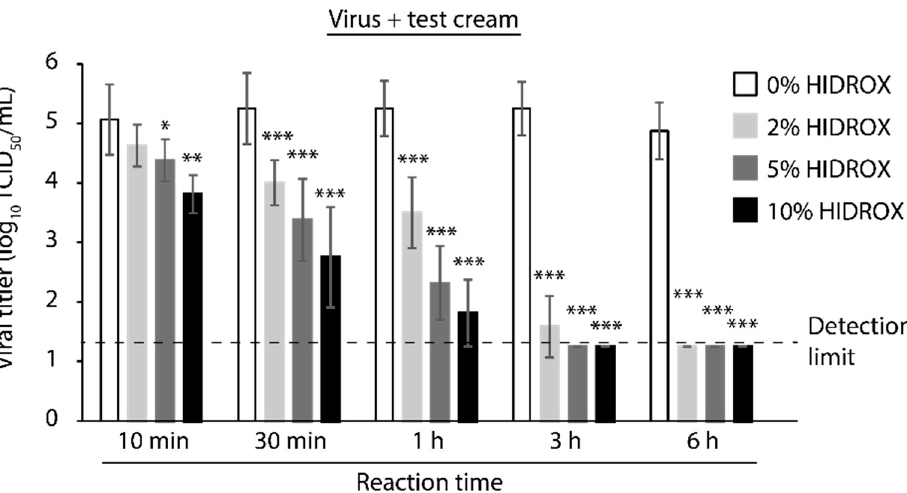
Figure 6. Time- and concentration-dependent virucidal activity of hydroxytyrosol (HT)-rich aqueous olive pulp extract (HIDROX)-containing cream against severe acute respiratory syndrome coronavirus 2 (SARS-CoV-2). SARS-CoV-2 was covered by 0%, 2%, 5%, and 10% HIDROX-containing cream-coated films and incubated for 10 min–6 h at 25 °C. After the predetermined reaction times, the viral solutions were recovered and the viral titers were calculated. The detection limit of the viral titer is 1.25 log 10 50% tissue culture infective dose (TCID 50 )/mL in all groups. Results are indicated as mean ± SD ( n = 4–8 per group). Student’s t -test was performed to evaluate the statistically significant difference between the 0% HIDROX group and other groups; * p < 0.05; ** p < 0.01; *** p < 0.001.